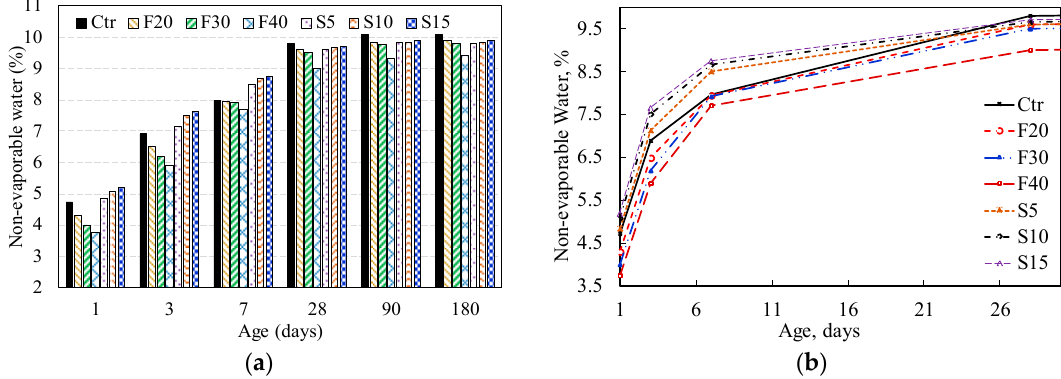
Figure 9. Non-dehydrated water content in control and binary blended paste systems with w/b ratio 0.3, mist cured, at ages ( a ) 1, 3, 7, 28, 90 and 180 days ( b ) 1, 3, 7 and 28 days.